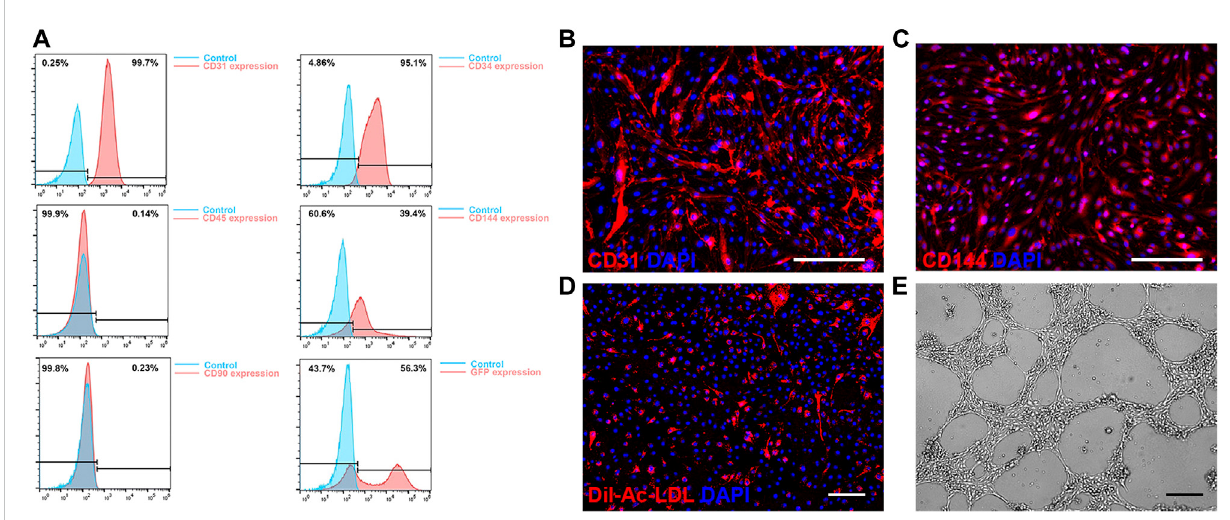
FIGURE 1 Characterizationofmousebonemarrowderivedendothelialcells(ECs). (A) FlowcytometryofCD31,CD34,CD45,CD144andCD90expressionand GFP transduction on ECs. (B, C) Immuno fl uorescence staining results of expression of CD31 (B) and VE-Cadherin (C) . (D) Acetylated low-density lipoprotein uptake by ECs. (E) Representative phase contrast image of in vitro tube formation of ECs. Scale bar = 200 μ